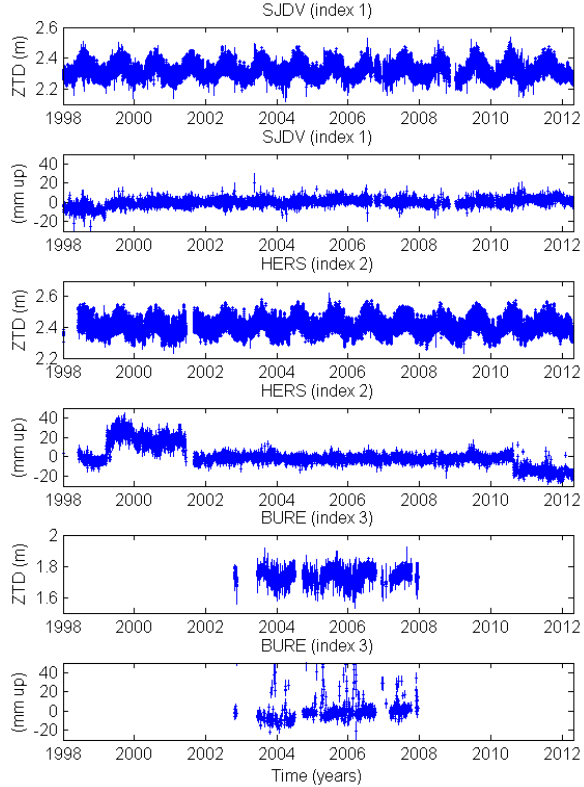
Figure 2. ZTD and vertical position time series for stations of index 1, 2, and 3 (SJDV, HERS and BURE).